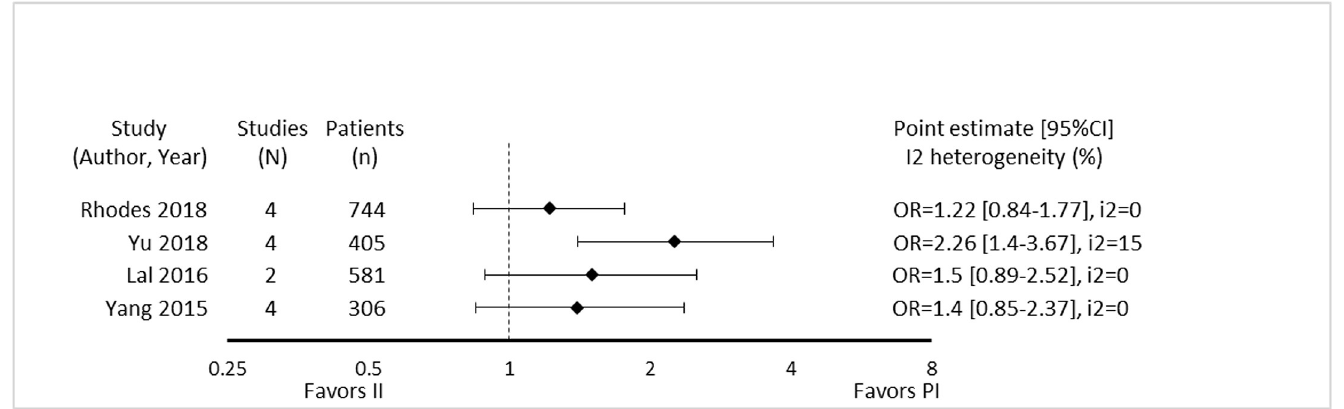
Fig 10. Effect of prolonged infusions versus intermittent infusions of beta-lactam antimicrobials on microbiologic cure.